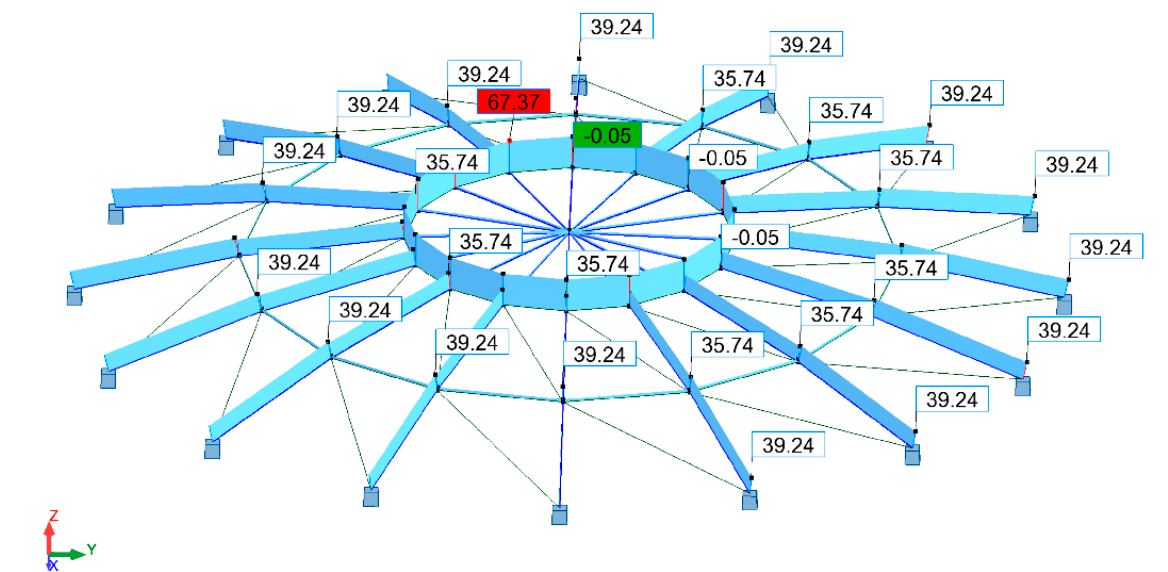
Figure 11. Structural stresses according to von Mises stress hypothesis [MPa].